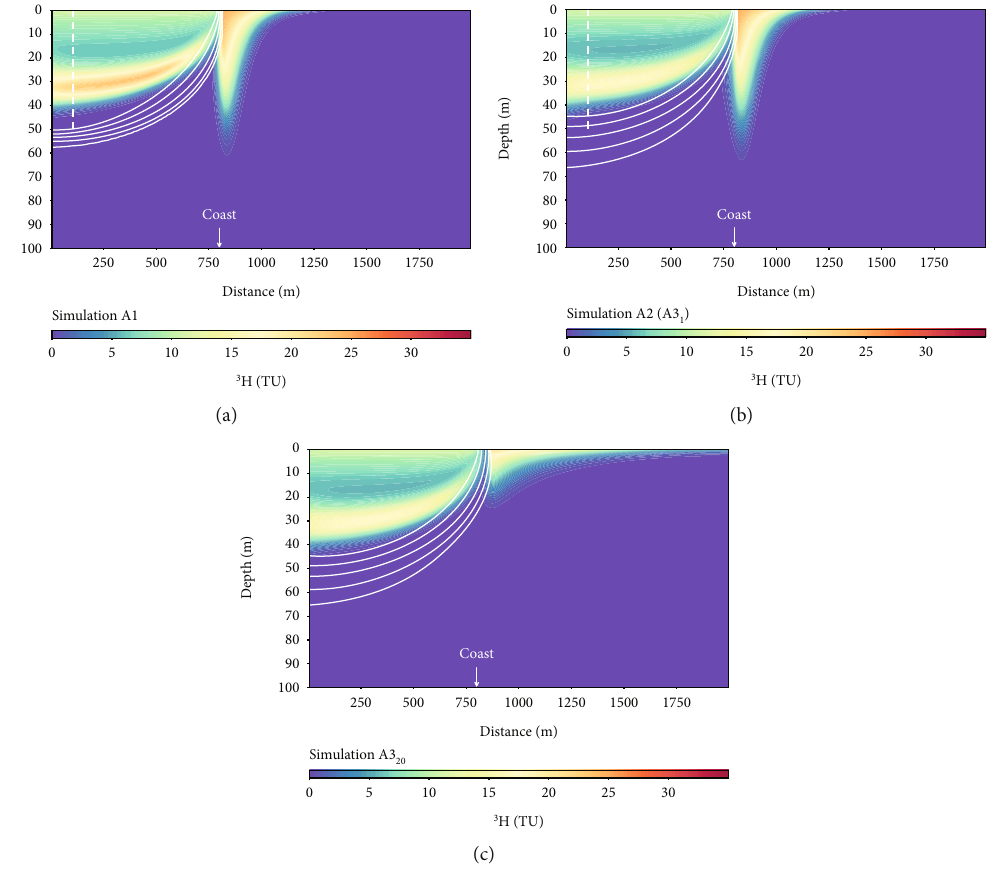
Figure 5: Cross sections showing contour plots of the simulated 3 H concentrations (shaded colours) and Cl concentrations (white lines) at the end of the simulation period (31 December 2013). The fi ve white lines represent Cl concentrations equal to 2.5%, 16%, 50%, 84%, and 97.5% of the seawater chloride concentration (17g/L). Results are shown for simulations (a) A1, (b) A2 (=A3 white line in (a) and (b) indicates the position of the vertical pro fi les shown in Figure 7.